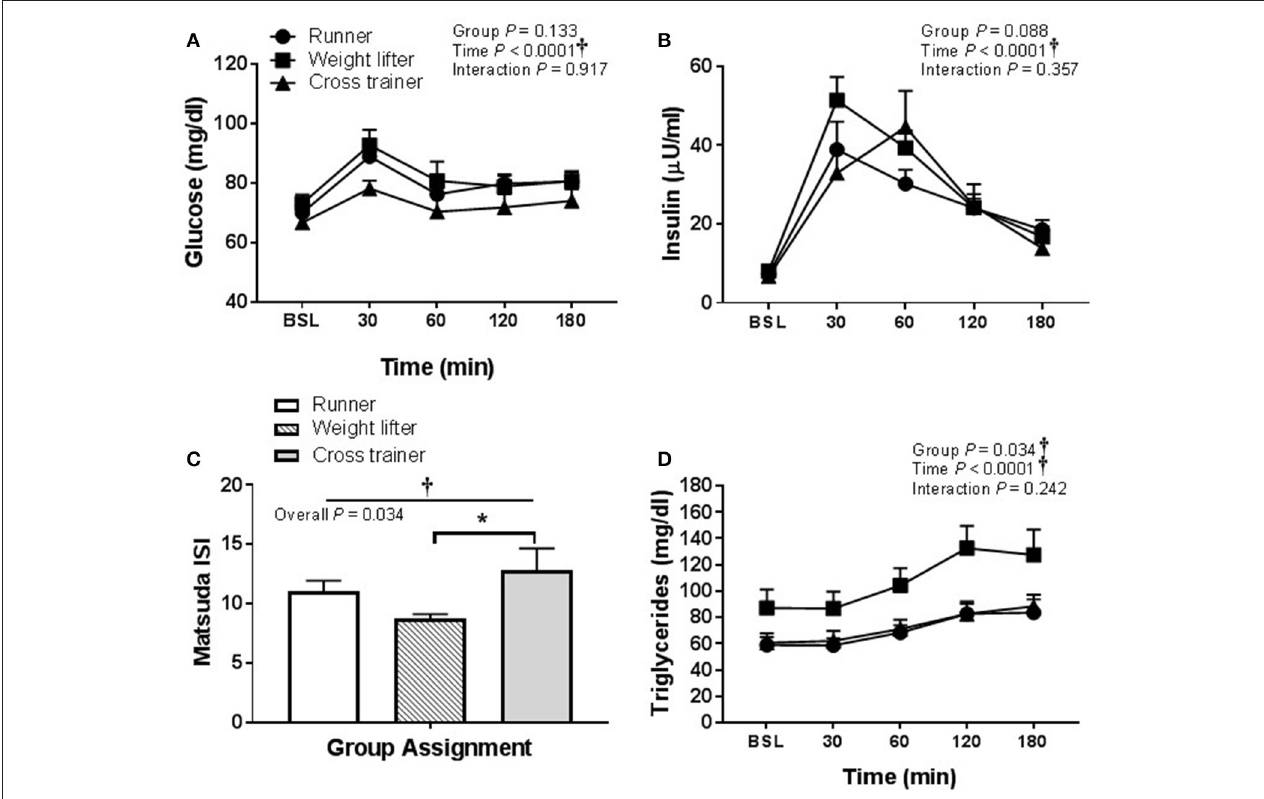
FIGURE 10 | Metabolic responses at baseline, and 30, 60, 90, 120, and 180min to a high fat mixed meal (HFMM) in runners ( n = 11), weightlifters ( n = 13), and cross-trainers ( n = 9). (A) Blood glucose response over 180min. (B) Serum insulin levels over 180min. (C) Matsuda insulin sensitivity index (ISI) and (D) Serum triglyceride levels over 180min. All data presented as mean ± SEM. † Indicates significant main or interaction effect ( P < 0.05). *Indicates significant difference between groups (adjusted P < 0.05; Sidak-Bonferroni adjustment for ANOVA multiple